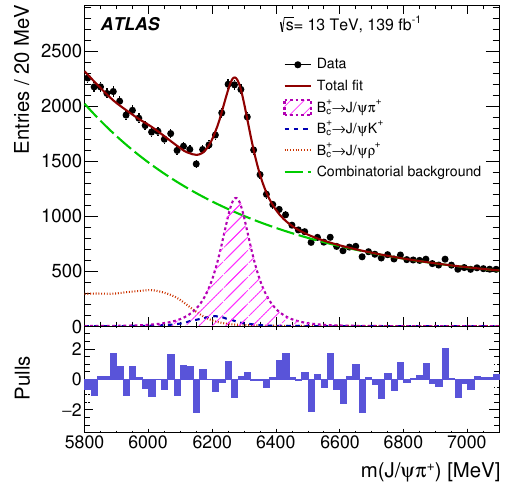
Figure 3 . Distributions of the J/ψπ + mass for the selected B + → J/ψπ + candidates. Data c are shown as points, and the overall result of the fit is given by the red solid curve. The signal contribution is shown by the purple shaded area. The red dotted, blue dashed, and green long- dashed lines correspond to the B + → J/ψρ + , B + → J/ψK + , and combinatorial background c c contributions, respectively. The bottom panel shows the pulls, defined as the difference between the data and the fit function divided by the uncertainty of the data